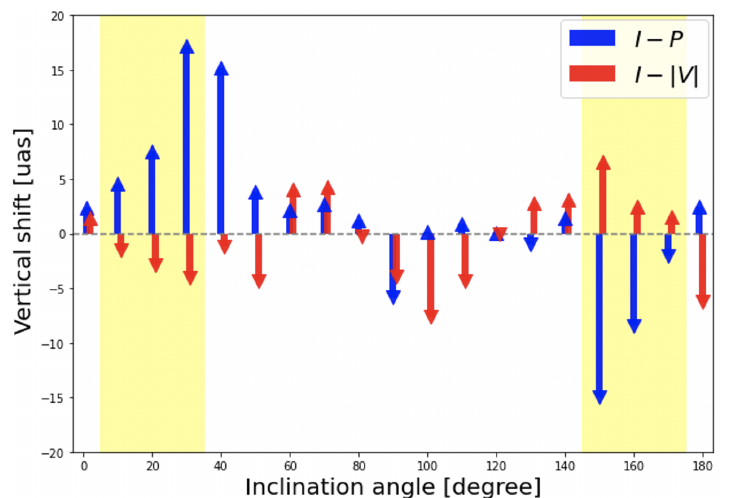
Figure 6. Diagram of separations in y -direction in Figure 2 (the direction of projected SMBH spin axis) between total and LP (or CP) intensities at 230 GHz for different inclination angles. The LP (or CP) intensities tend to be distributed downstream (upstream) of the jet for Faraday thick cases. Arrows point to the distances of separations in the vertical direction of the images between total and LP (or CP) intensity distribution in blue (or red) color. The separations are calculated from cross-correlation function between two kinds of intensities on the images. See Tsunetoe et al. [18] for introduction and definition of the correlation